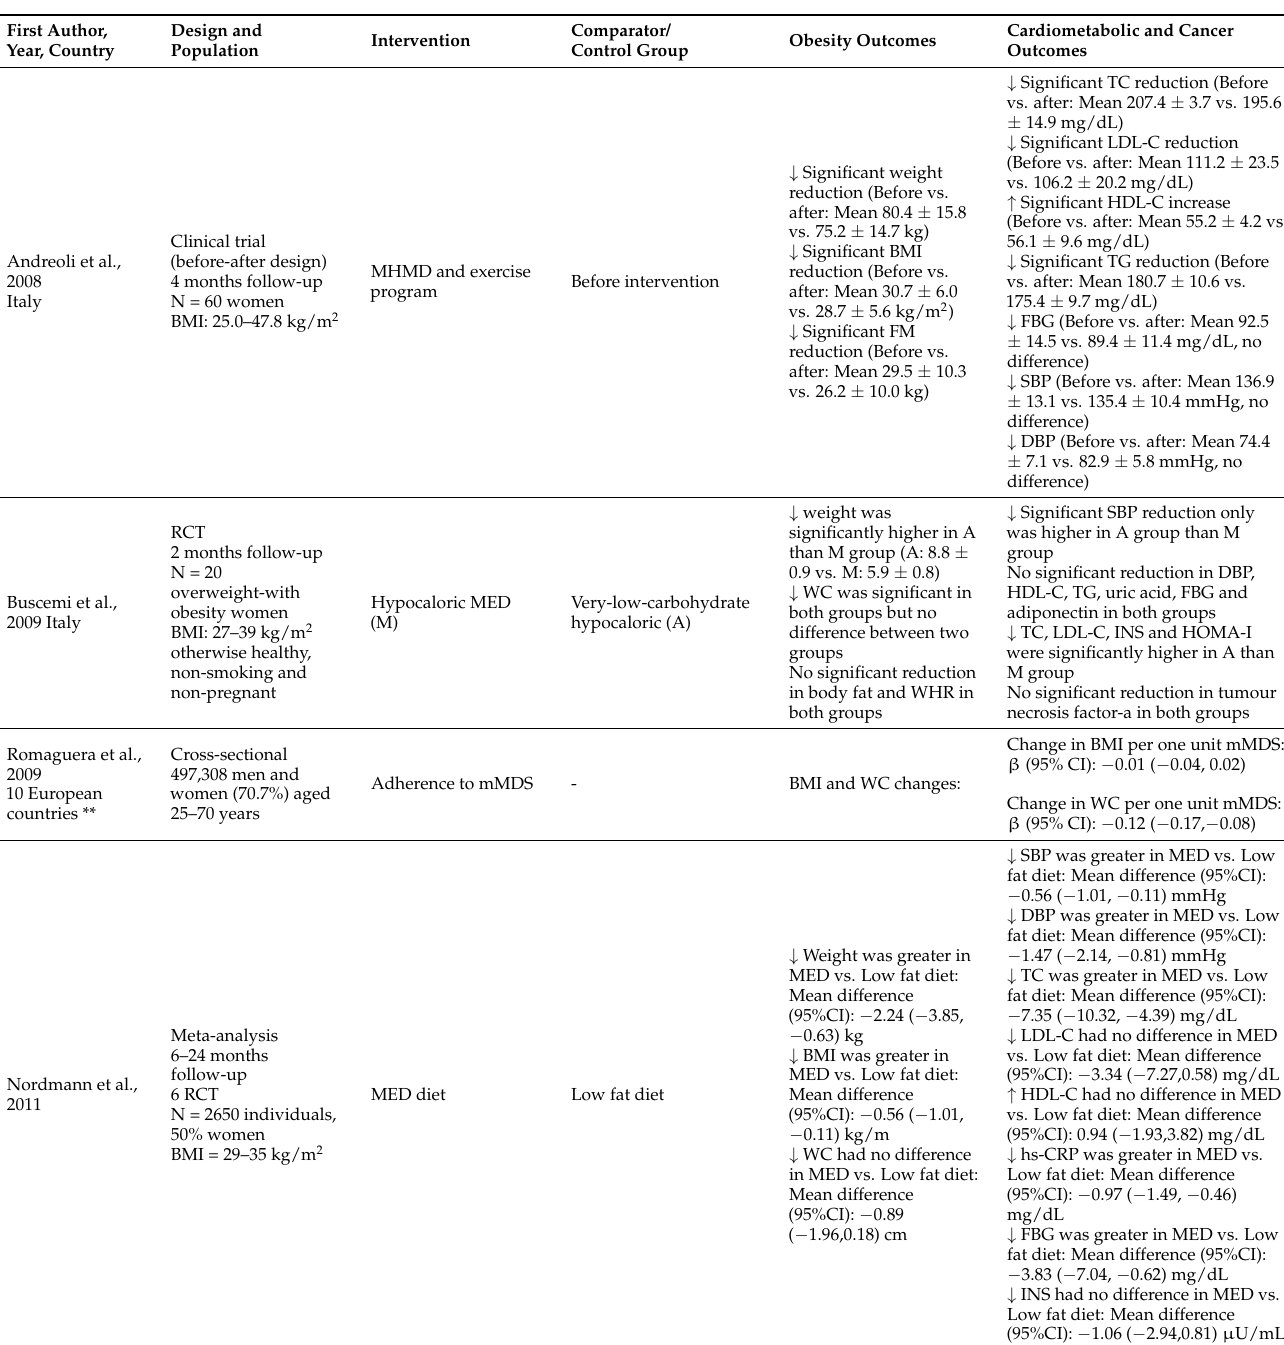
Table 2. Summary of studies with the Mediterranean diet (MED) for weight loss, obesity and cardiometabolic and cancer